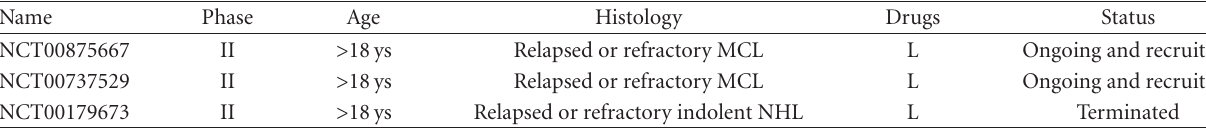
Table 2: Ongoing lenalidomide (L) monotherapy